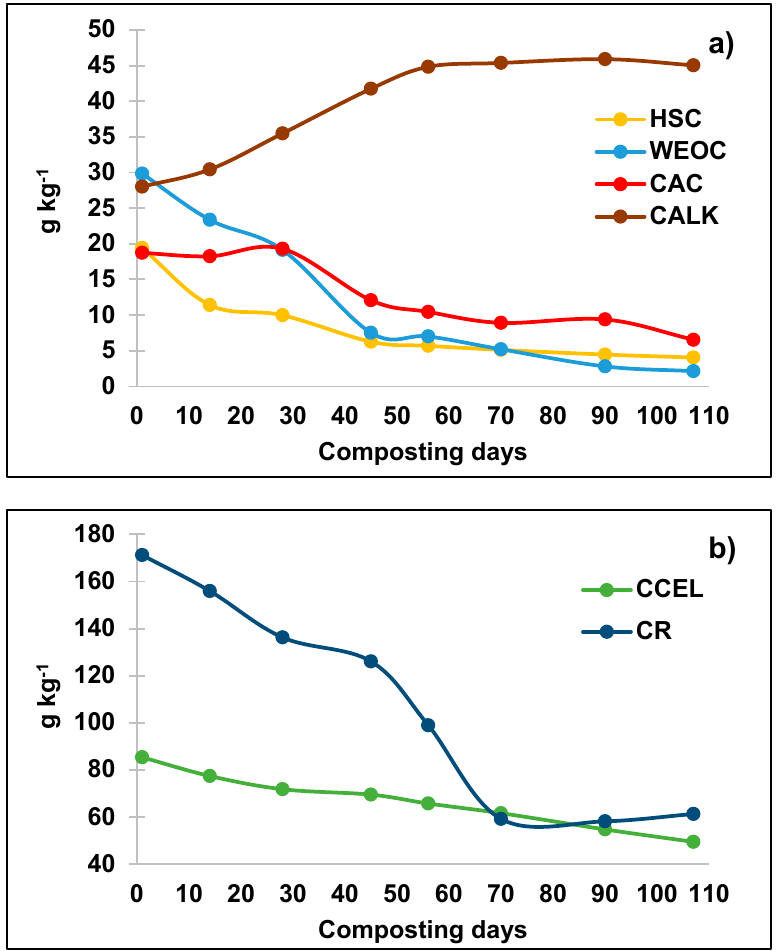
Figure 4. Changes in: ( a ) HSC, WEOC, C AC and CALK, and ( b ) C CEL and CR during the composting of MSW (markers: measured values; lines—mean values).